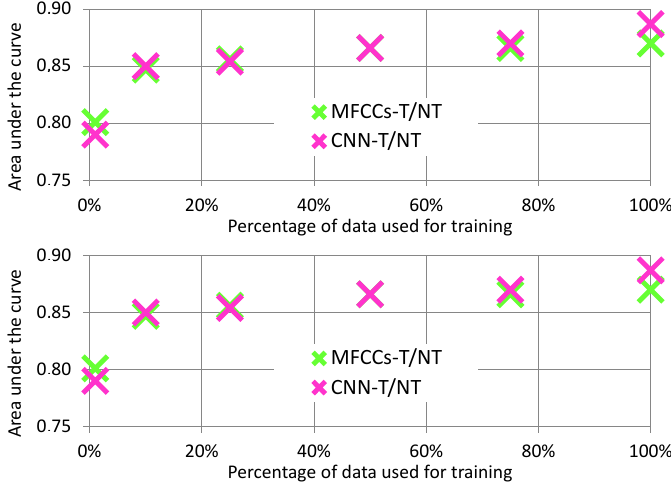
Figure 8. Analysis of AUC values over varying amounts of training data. ( Top ): Data reduced for feature learning only. Mel Frequency Cepstral Coefficients after Tremor Spectrum Extraction (MFCCs-T/NT) features are not learned, which means they are independent of dataset size. ( Bottom ): Data reduced for both feature learning and MLP